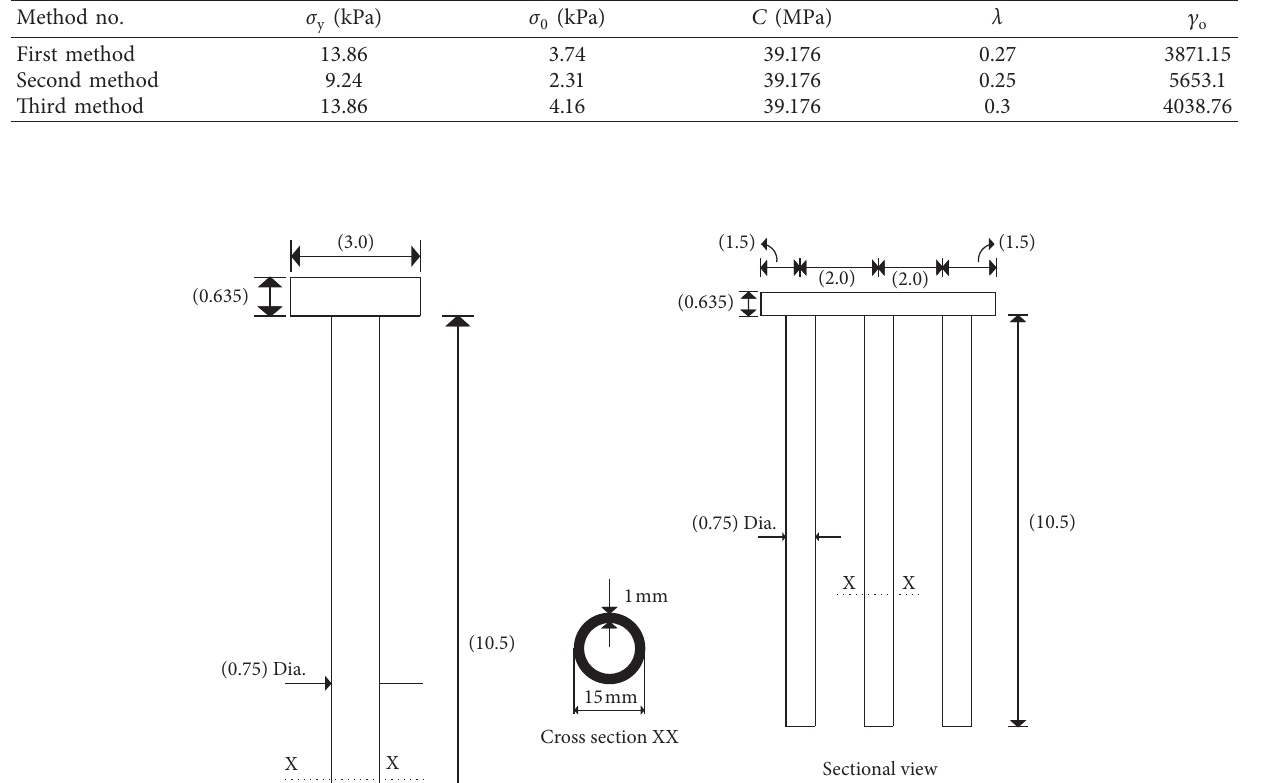
Table 2: Mechanical properties of soft clay based on the three different calibration methods. Method